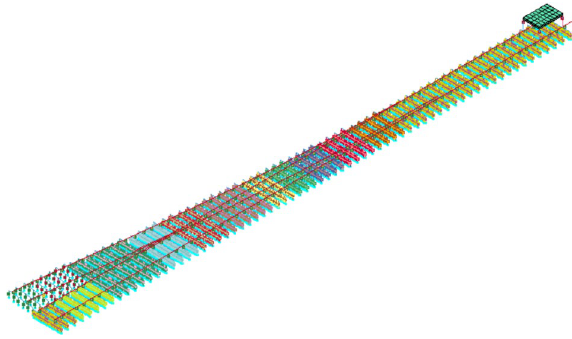
Figure 2. The 3D vehicle-slab FEM model 40 .